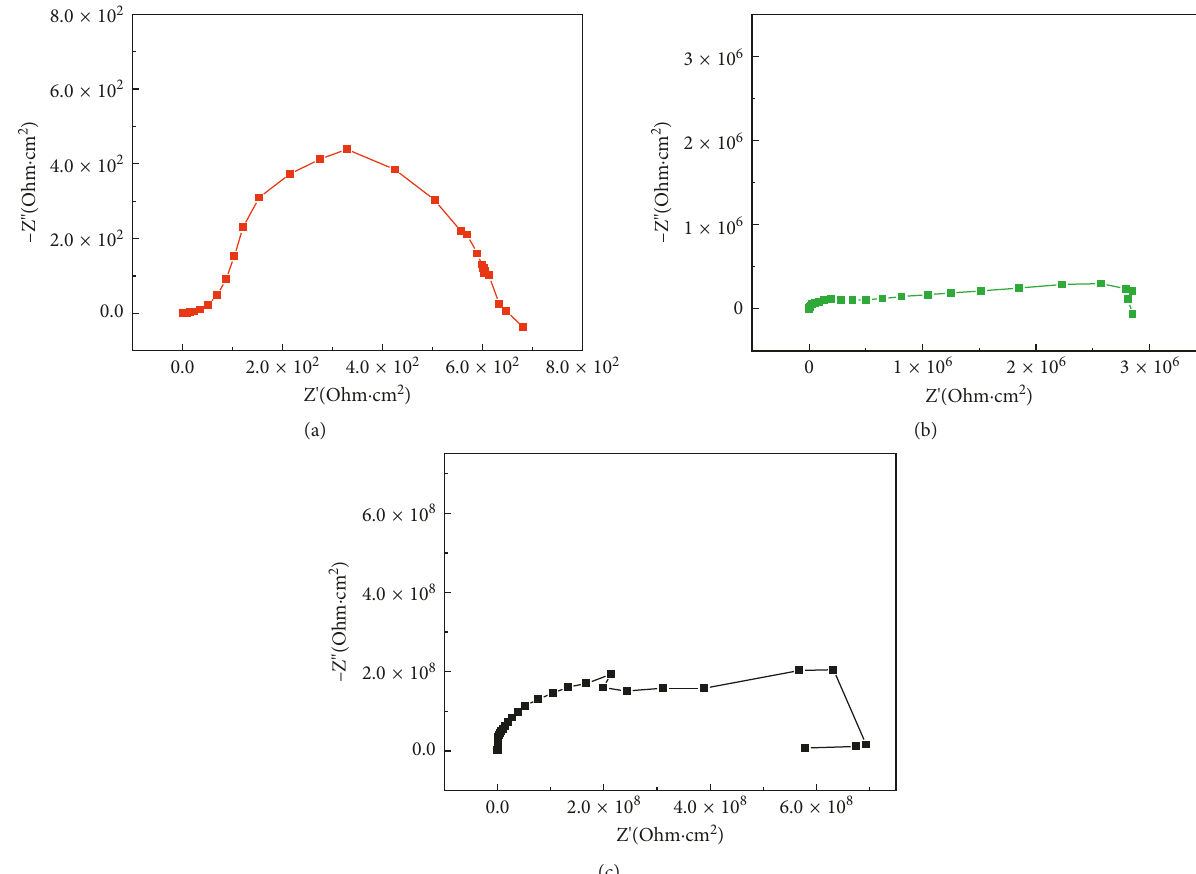
Figure 4: Nyquist plots of the three coatings: (a) AQ80M, (b) MAO coating, and (c) multiple coating. circuits, R s represents the resistance between the working electrode and reference electrode. Q c is related to the ca- pacitance of the coating. R c is the resistance of the pores and